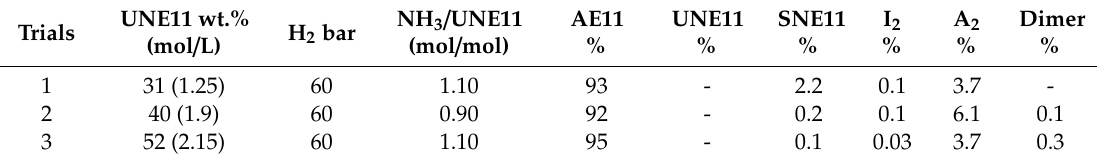
The influence of UNE11 concentration on the hydrogenation reaction